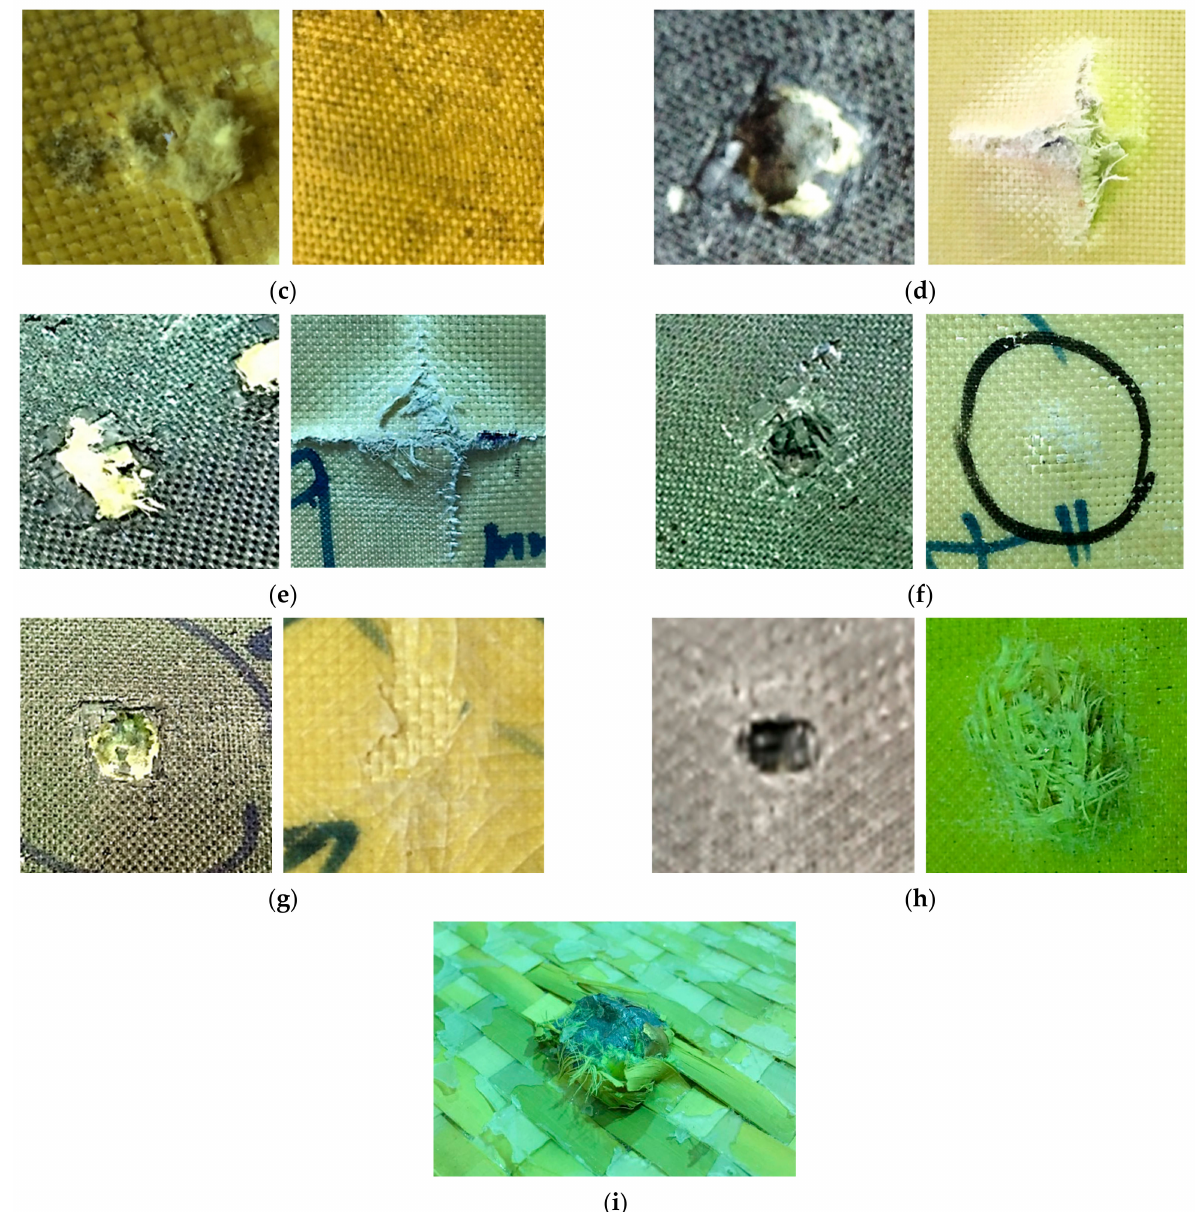
Figure 5. The deformed plates after the ballistic test: ( a ) strike face (left) and back face (right) of the flat non-hybrid [KFRP 40 ] plate (#1), sample 1, shoot 1; ( b ) path of the stopped bullet between KFRP layers in the flat non-hybrid [KFRP] 40 plate (#1); ( c ) strike face (left) and back face (right) of the curved non-hybrid [KFRP 40 ] plate (#2), sample 2, shoot 1; ( d ) strike face (left) and back face (right) of the flat hybrid [CFRP 4 /KFRP 6 ] 4 plate (#3), sample 1, shoot 1; ( e ) strike face (left) and back face (right) of the curved hybrid [CFRP 4 /KFRP 6 ] 4 plate (#4), sample 3, shoot 1; ( f ) strike face (left) and back face (right) of the flat hybrid [CFRP 10 /KFRP 30 ] plate (#5), sample 1, shoot 1; ( g ) strike face (left) and back face (right) of the curved hybrid [CFRP 10 /KFRP 30 ] plate (#6), sample 2, shoot 1; ( h ) strike face (left) and back face (right) of the flat [CFRP 4 /[DPRP 2 /KFRP 10 ] 3 ] plate (#7), sample 3, shoot 1; ( i ) stopped bullet inside the [CFRP 4 /[DPRP 2 /KFRP 10 ] 3 ]